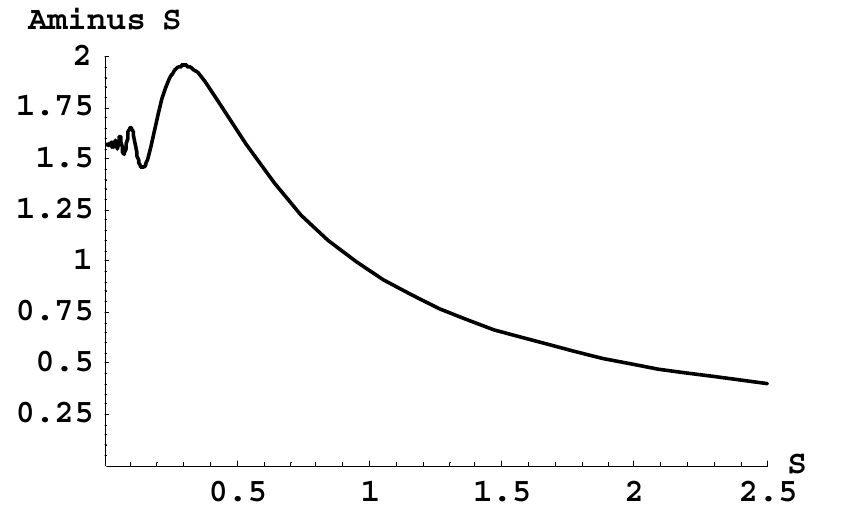
Figure 9. The integrand A − (s)/s, corresponding to the widths function a − , versus s = Z/ γ , where Z is the scaled impact parameter defined by Equation (8.2) and γ is the relativistic factor defined by Equation (8.3) [82].